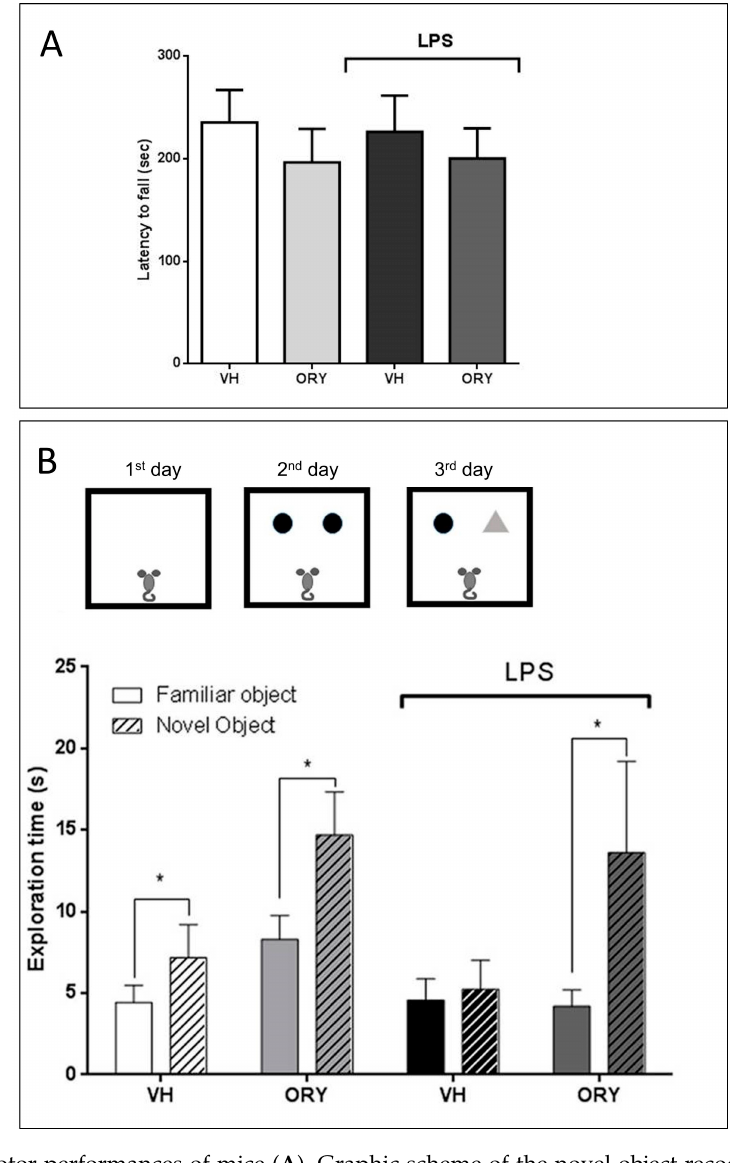
Figure 2. Motor performances of mice ( A ). Graphic scheme of the novel object recognition (NOR) test protocol and data of time spent exploring the familiar and novel objects are reported. For all experimental conditions, the full color bars represent the familiar object, while the patterned bars represent the novel object ( B ). Data are expressed as the mean ± S.E.M. Two-way ANOVA tests with Sidak’s multiple comparisons test were used to test statistical significance (* p < 0.05 vs. the familiar object). VH: vehicle; ORY: γ -oryzanol; LPS: lipopolysaccharide.